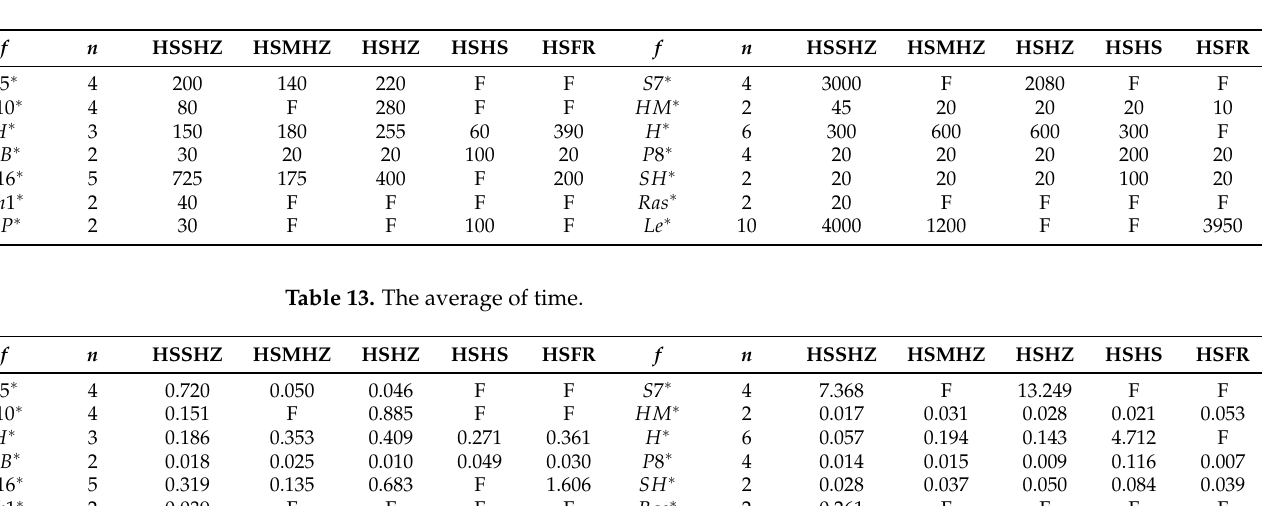
Table 12. The number of best function evaluations.